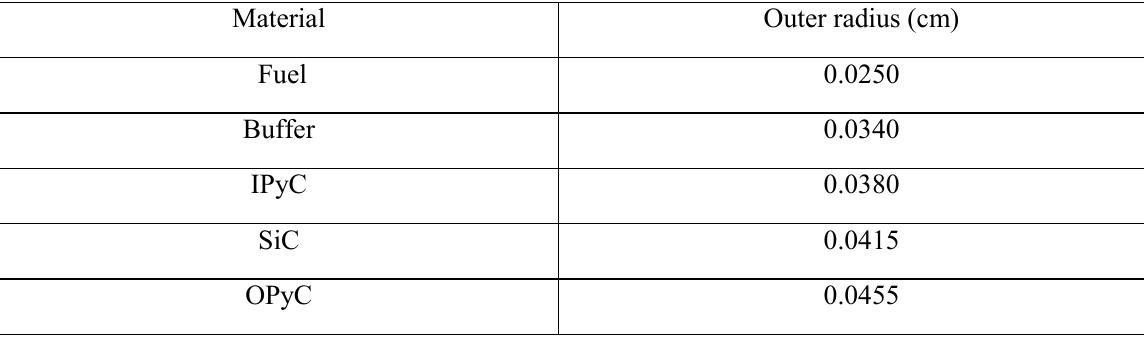
Table II Material and geometry of the pin cell problems